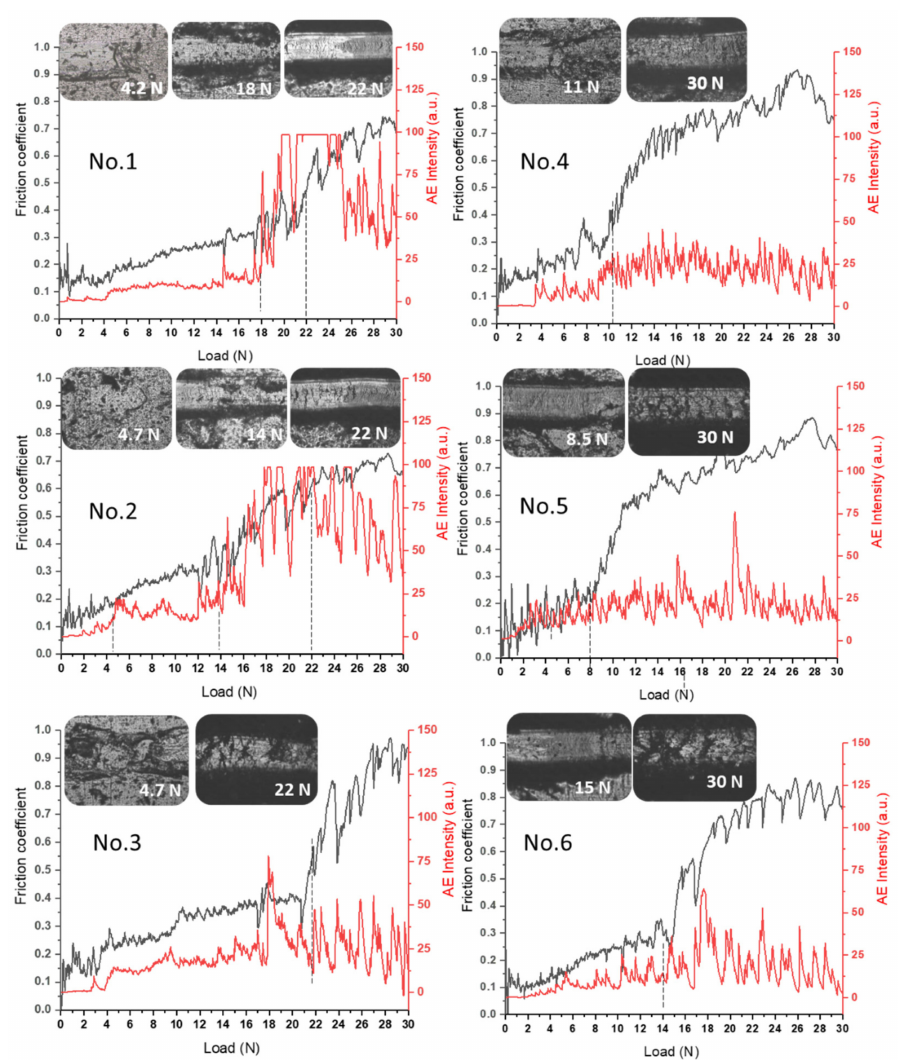
Figure 6. Results of scratch testing of (TiZrNb)N